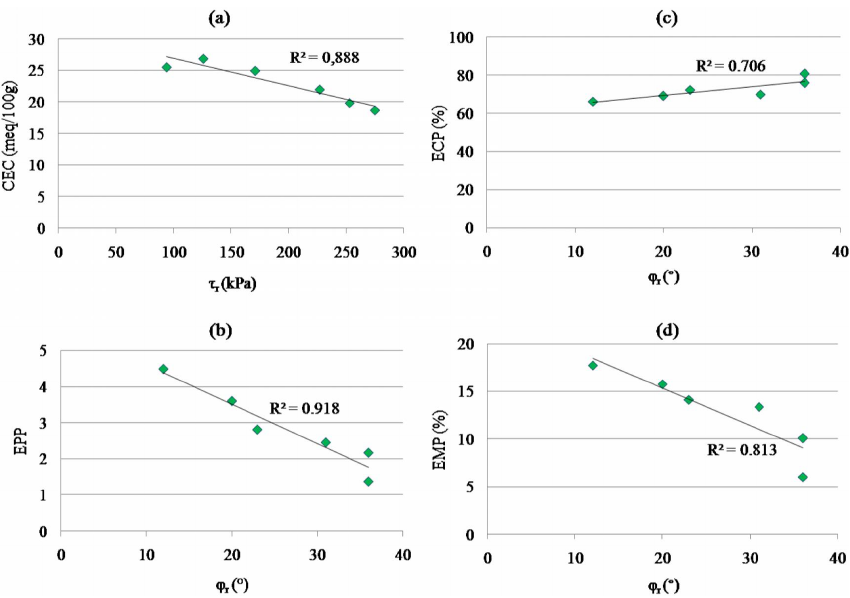
Figure 14. Correlations between some geochemical and mechanical characters (CEC = cation exchange capacity; EPP = exchangeable potassium percentage; ECP = exchangeable calcium percentage; EMP = exchangeable magnesium percentage; τ r = residual shear strength; ϕ r = residual friction